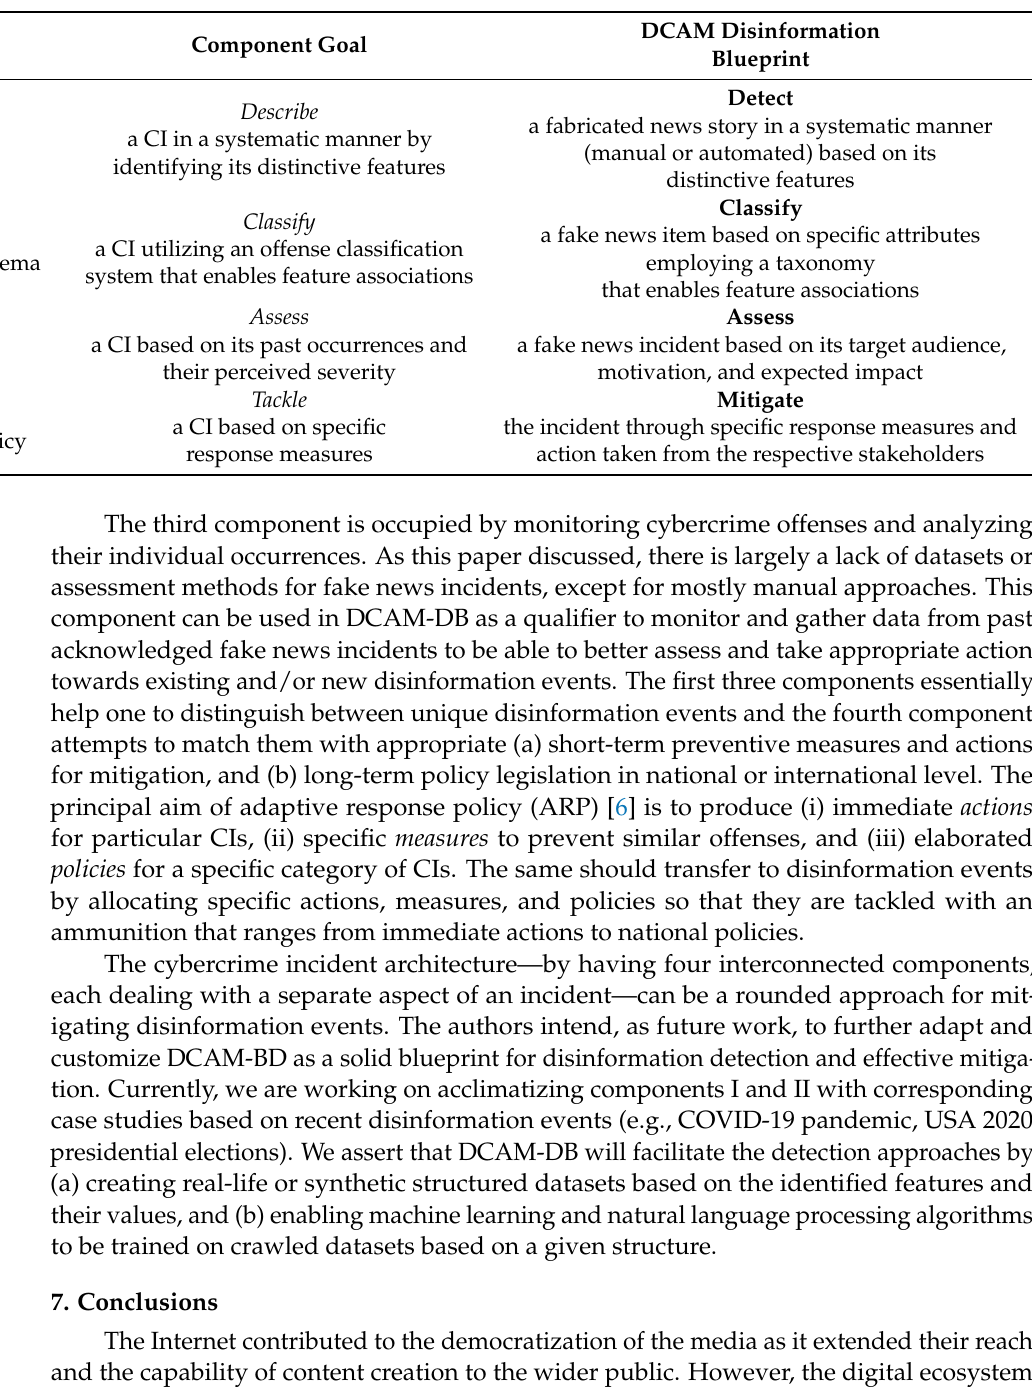
Table 2. CI architecture’s components [6] as qualifiers for